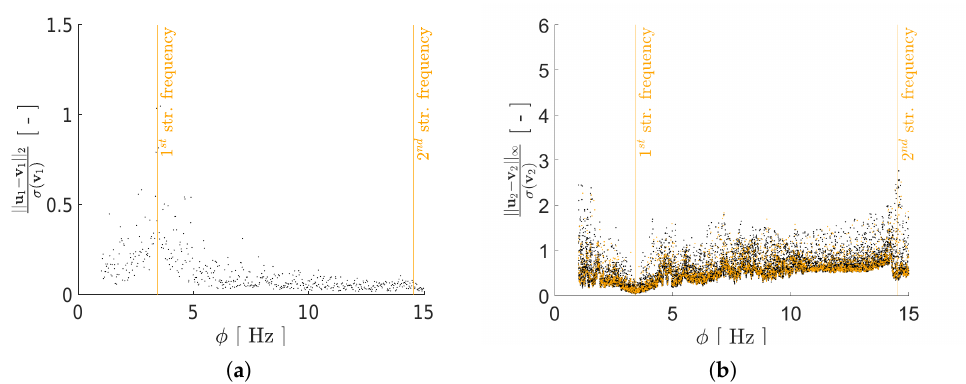
Figure 13. Two-storey shear building, configuration B, P = 4. Reconstruction errors as a function of the load frequency φ : ( a ) standardized L 2 norm relevant to the floor displacement v 1 for the test set; ( b ) standardized L ∞ norm relevant to the floor displacement v 2 for the training (black dots) and validation (orange dots) sets.